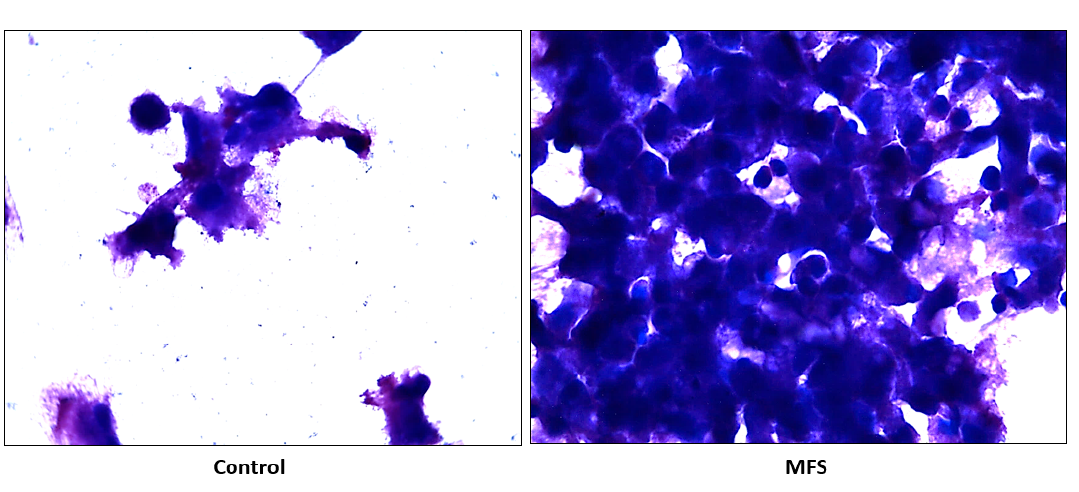
H&E staining of Mtb infected peripheral blood mononuclear cells (PBMCs) illustrates an increase in cell survival with MFS administration versus sham treatment after 15 days of infection